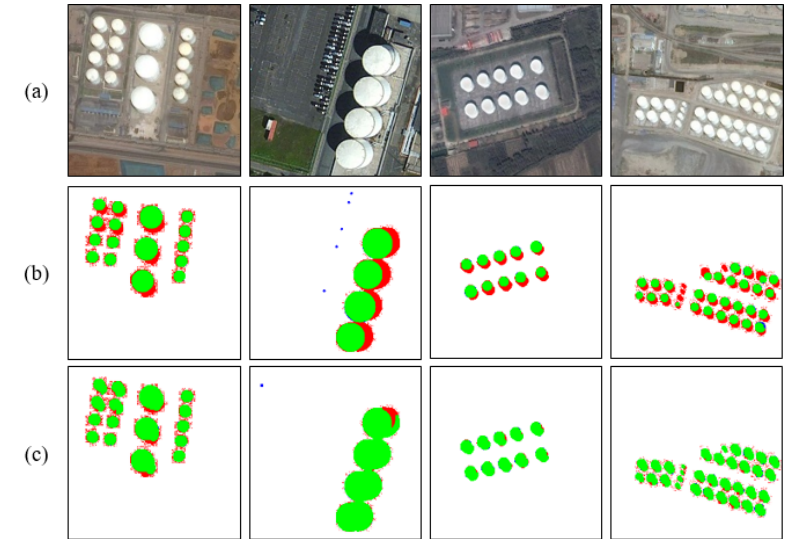
Figure 10. Comparison of two detection methods when the oil tank is at a certain angle. ( a ) is the input image, ( b ) is the method from Ok, ( c ) is our method.